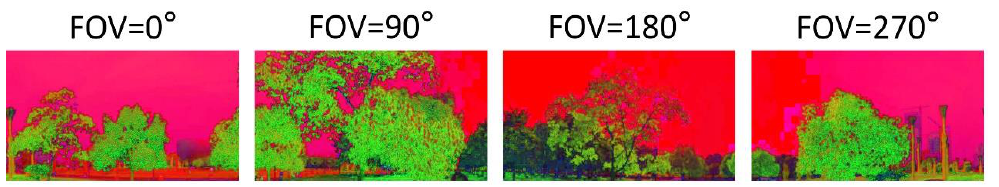
Figure 5. Recognition result of each street-view image.